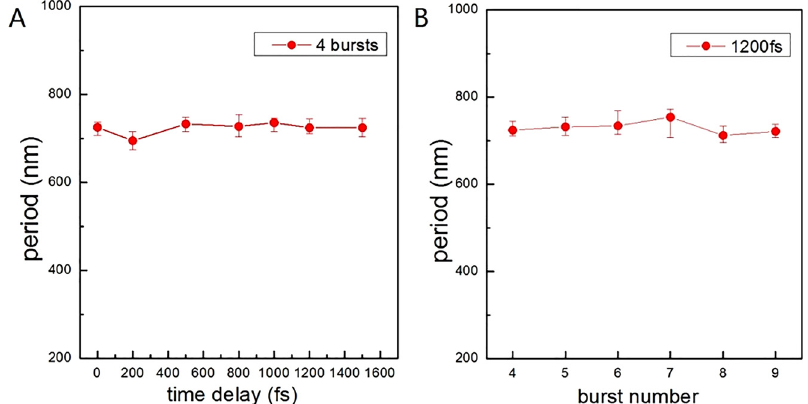
Figure 4: (A) Plot of the period of the concentric rings against the time delay at a burstnumberof4.(B)Plotoftheperiodofthe concentric rings against the burst number at a double-pulse time delay of 1200